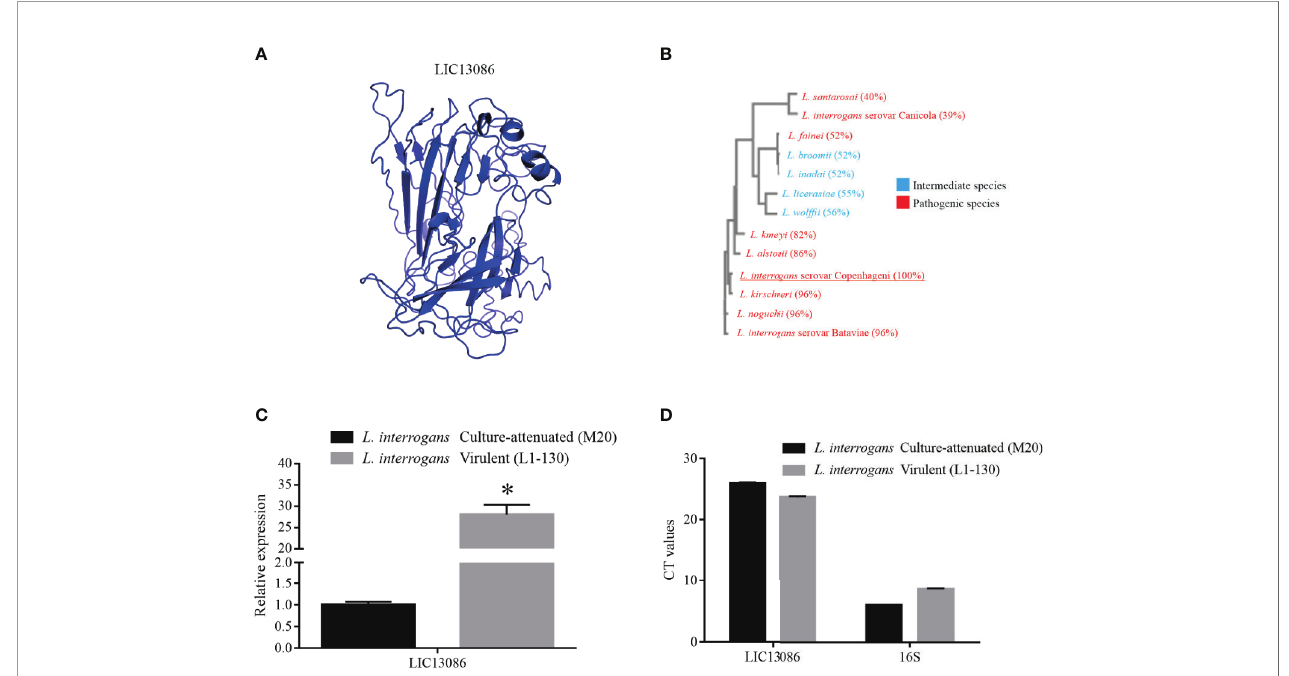
FIGURE 1 | In silico analysis of LIC13086 and real-time PCR native expression quanti fi cation. (A) Tertiary model of LIC13086 generated by molecular modeling in the I-TASSER webserver and visualized by PyMoL. (B) Dendogram resulting of multiple alignments performed by Clustal Omega of LIC13086 with other similar sequences of different species of Leptospira identi fi ed by BLASTp (pathogenic in red; intermediate in blue). (C) LIC13086 relative gene expression in culture- attenuated and virulent strains of L. interrogans by qPCR. Gene expression was normalized to 16S gene. (D) CT values of mRNA expression in culture-attenuated and virulent strains of L. interrogans . The bars represent the means of three different experiments in triplicates with the corresponding standard deviation. *Indicates signi fi cant difference calculated by Student t- test with p-values <